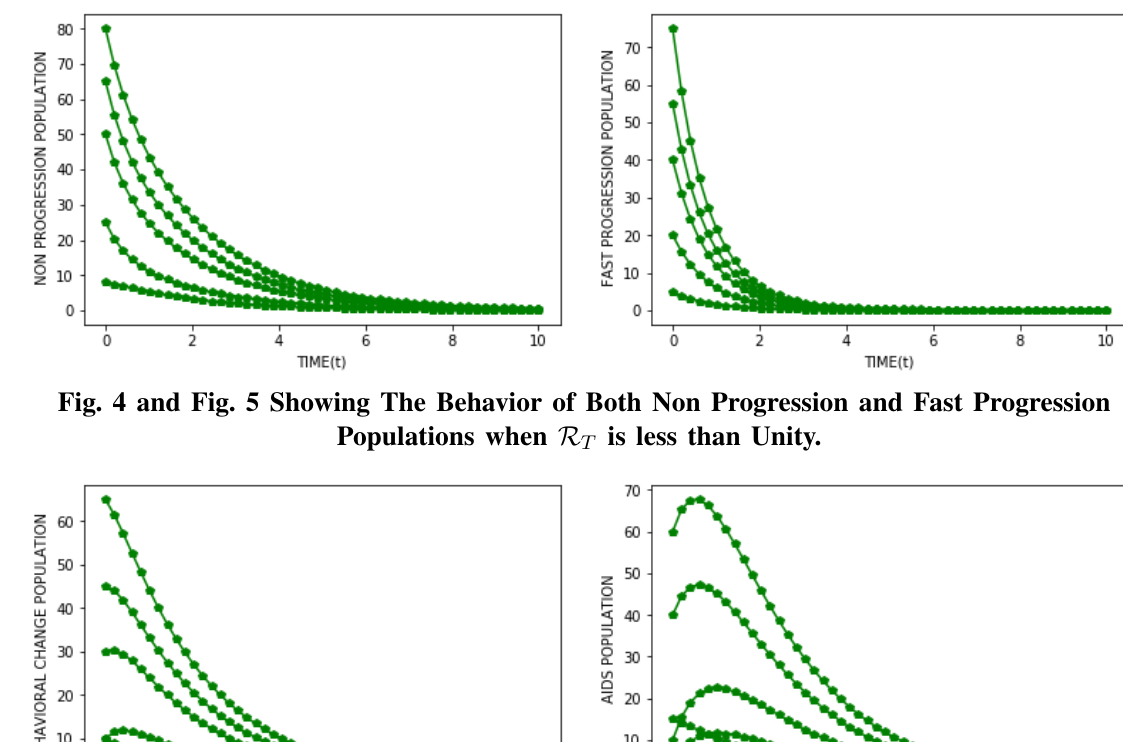
Fig. 2 and Fig. 3 Showing The Behavior of Both Susceptible and Slow Progression Populations when R T is Less Than Unity.